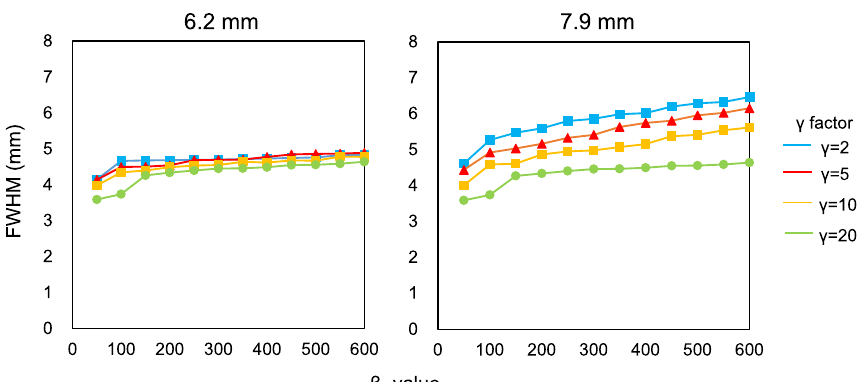
Fig. 8 Full width at half maximum determined by profile curves of 6.2- and 7.9-mm hot spheres as function of β 50–600 for each γ